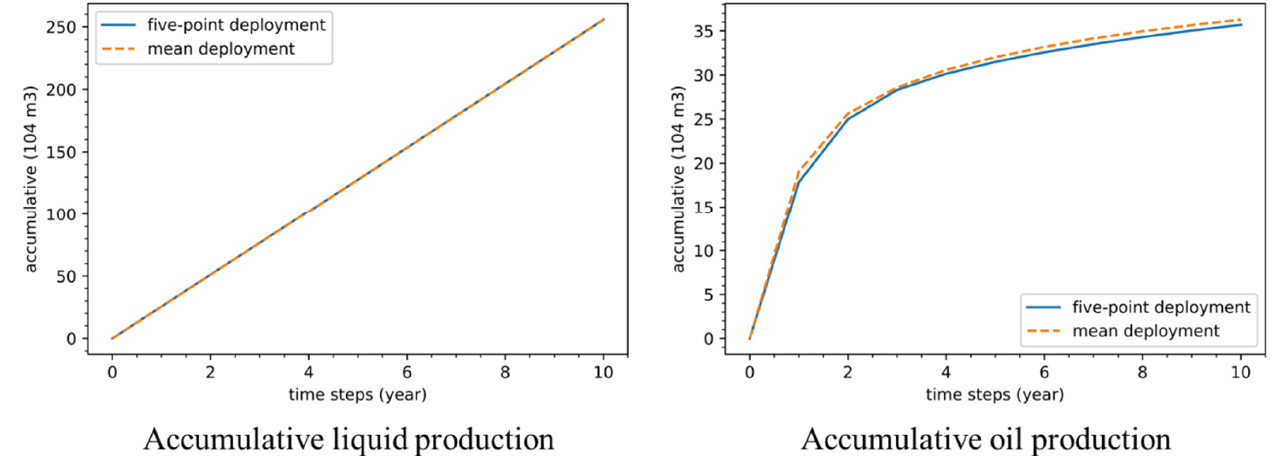
Figure 11. Accumulative liquid production and oil production of both methods.